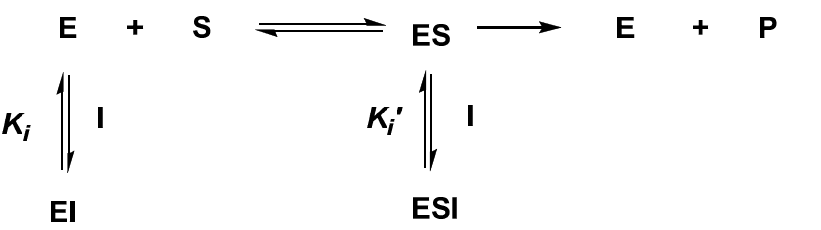
Figure 10. Lineweaver–Burk plots for inhibitory activity of 2 α -7f against rat intestinal sucrase ( a ). Secondary replots of ( b ) slope vs. [I] and ( c ) intercept vs. [I] from a primary Lineweaver–Burk plot for the determination of K i and K’ i , respectively.